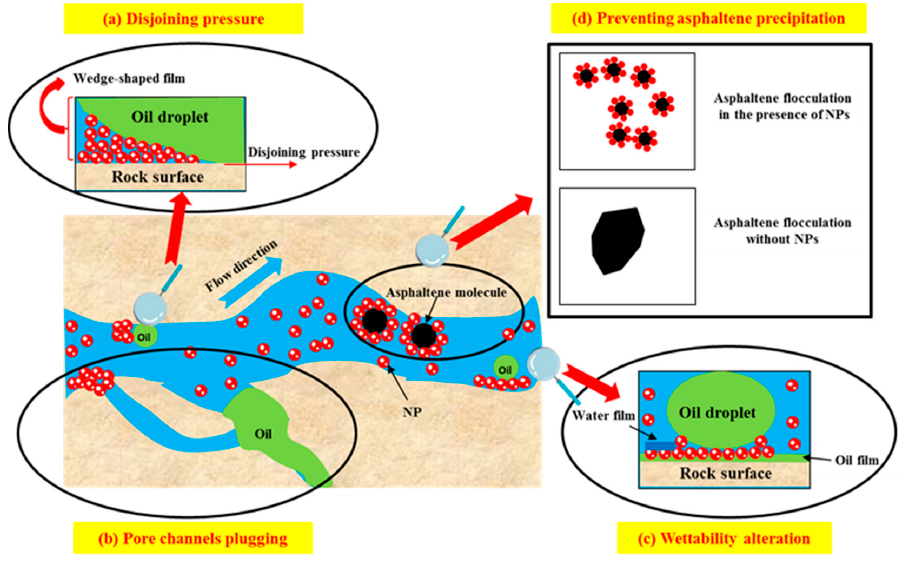
Figure 4. The schematic of the EOR mechanisms of nanofluids.